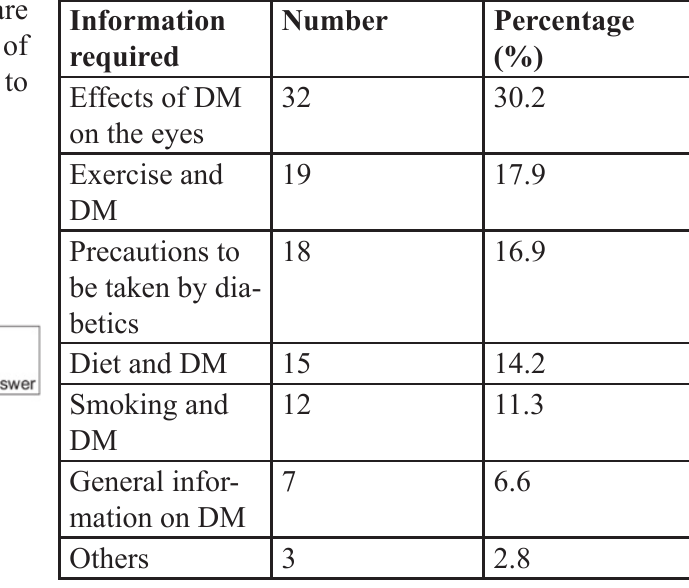
Table 2: The information that the respondents would like to get from the clinicians and percentage of respondents. Others in the figure refer to specific symptoms of DM (e.g.